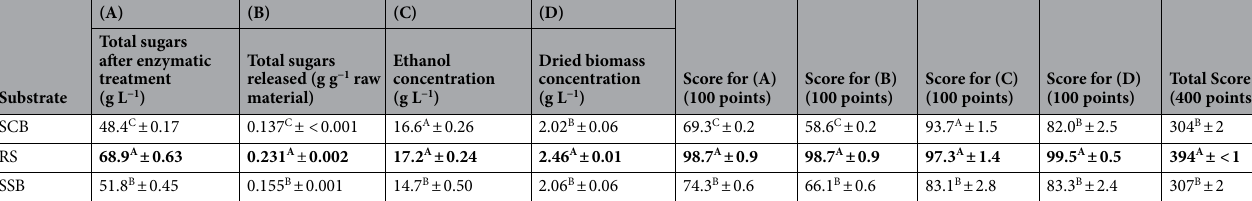
Table 2. Score ranking analysis to select suitable substrate for cultivation. Numbers with the same uppercase alphabet indicated no significant difference (p > 0.05) for comparison of the same column. Bold data indicated the best average value(s) within each column. Score ranking was calculated taking account of all the replicates of each criterion in Microsoft Excel spreadsheet. SCB, sugarcane bagasse; RS, rice straw; SSB, sweet sorghum